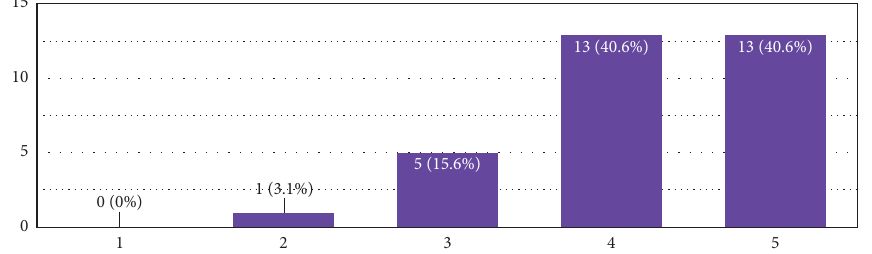
Figure 6: In the fgure, “1” means “not really” whereas “5” represents “understand the positive role well;” the remaining are the ex- trapolations in the middle per the Likert scale. Te Y -axis shows the number of responses.